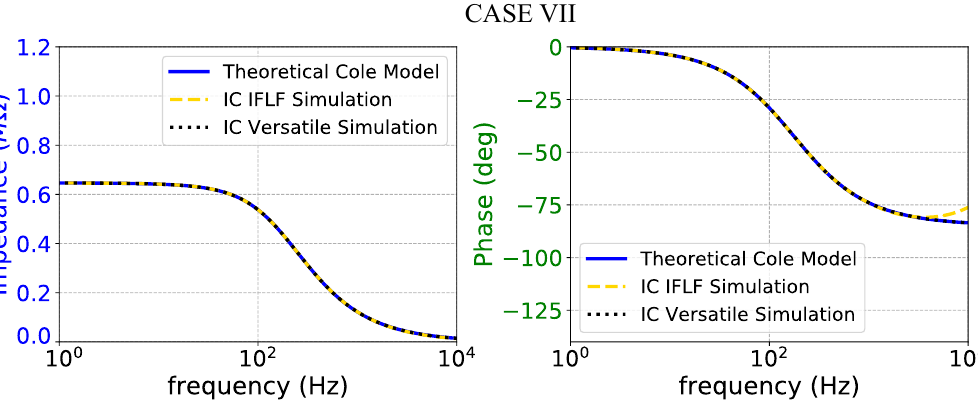
Figure 20. Impedance magnitude ( left ) and phase response ( right ) of the case VI fractional-order electrode model.